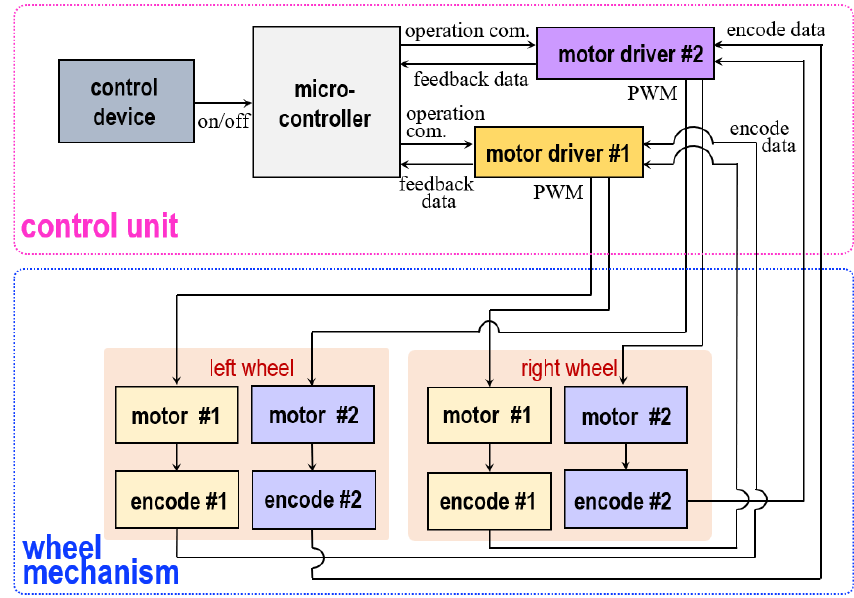
Figure 13. Control flow according to operation commands based on the control unit assembled in Figure